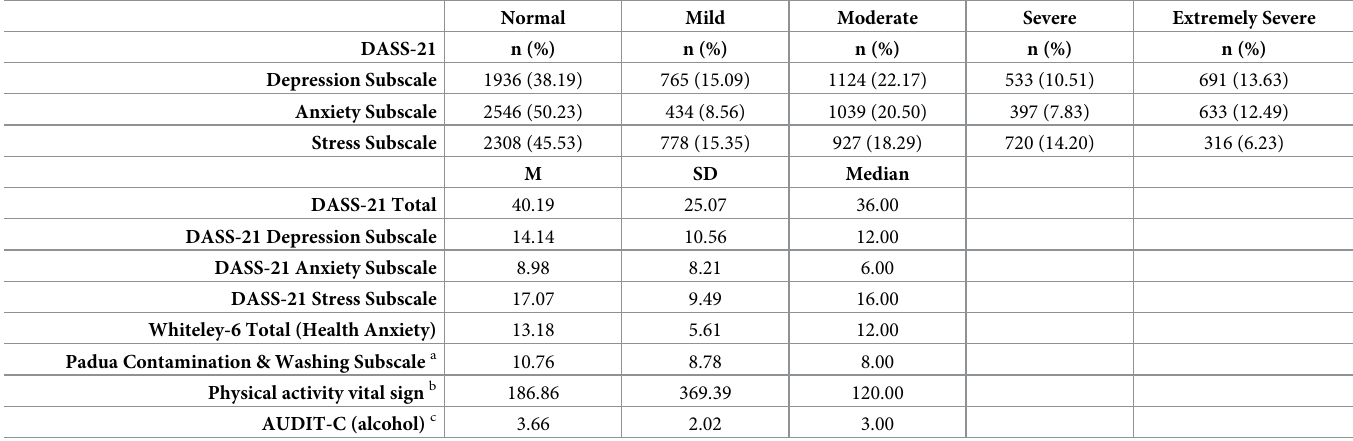
Table 3. Psychological distress, health anxiety, alcohol use, and physical